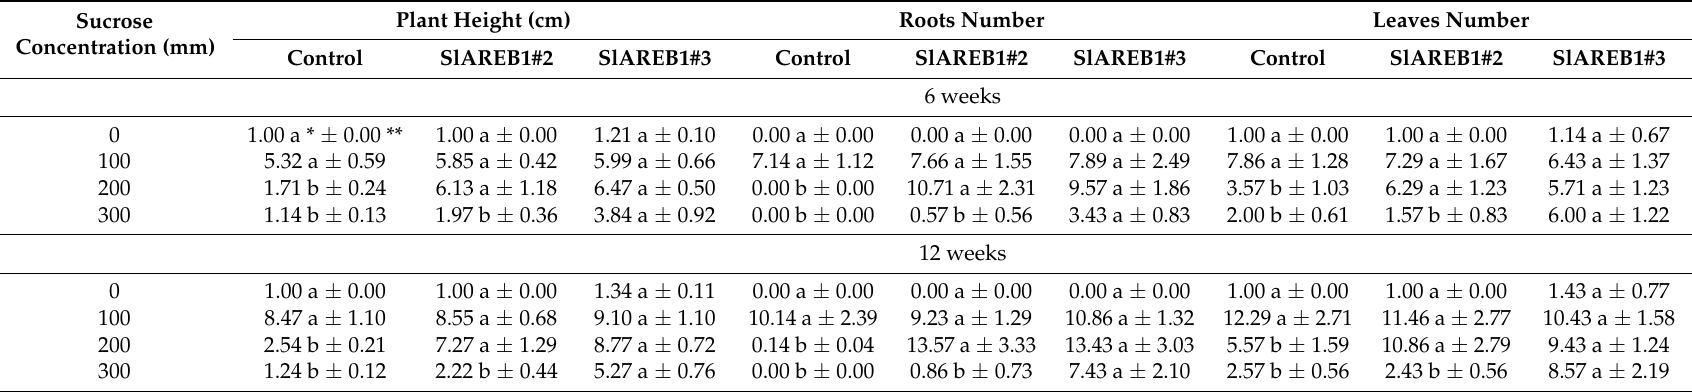
Table 1. Effects of sucrose concentration on plant height, roots number and leaves number of in vitro conserved microshoots of negative control, SlAREB1#2, SlAREB1#3 transgenic tomato plants after 6 and 12 weeks of storage.